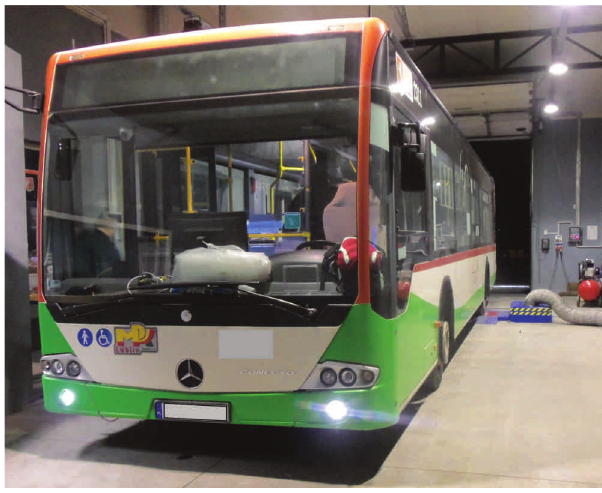
Fig. 1. Research object at the chassis dynamometer